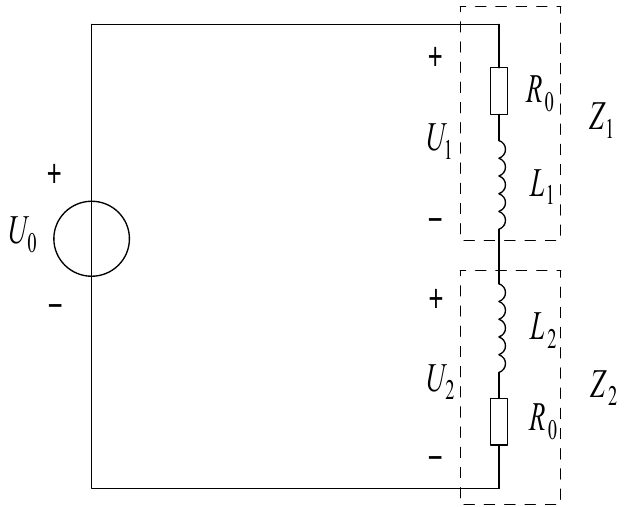
Figure 3. Equivalent circuit of the differential inductive sensor.